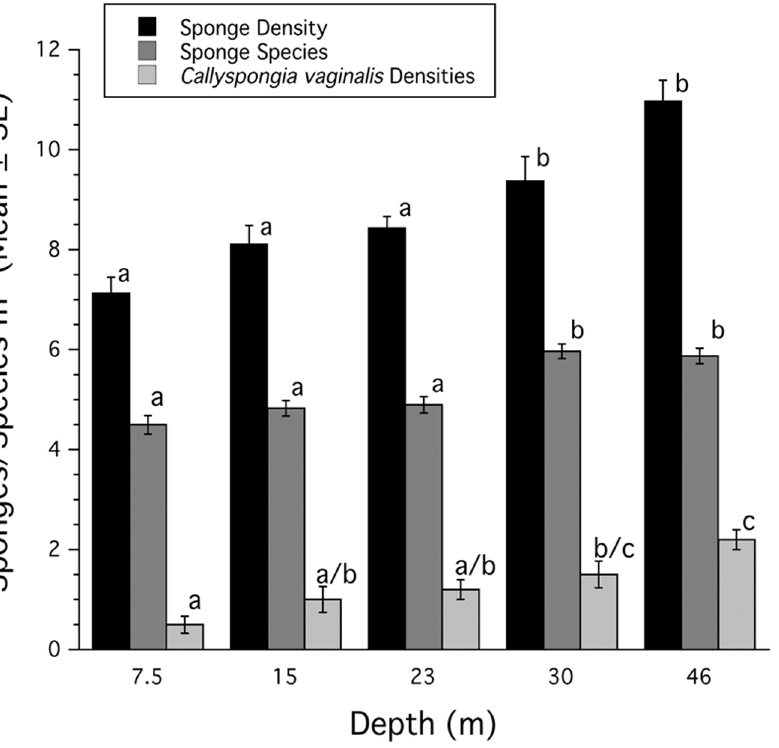
Figure 1. Sponge densities and diversity on Carrie Bow Cay, Belize (m 2 , mean ± SE). Density of sponges, number of sponge species and density of Callyspongia vaginalis from different depths. Common superscripts indicate groups not significantly different from each other.